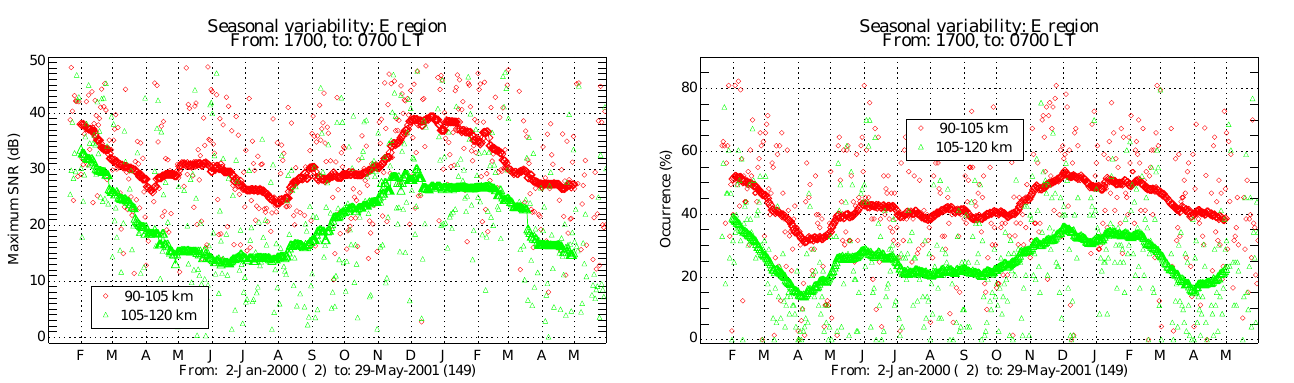
Fig.5. Seasonal variability of percentage of occurrence of lower E-region (red) and the upper E-region (green) irregularities. The thicker symbols represent 60-day median averages.